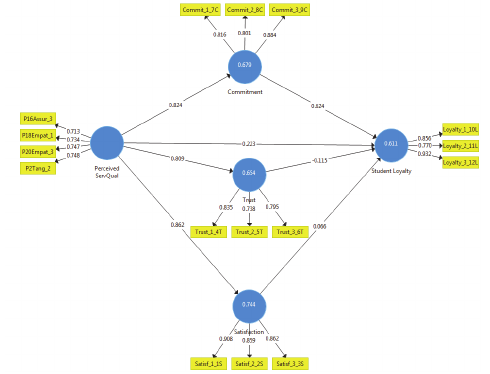
Fig. 1. Estimated Structural Student Loyalty model